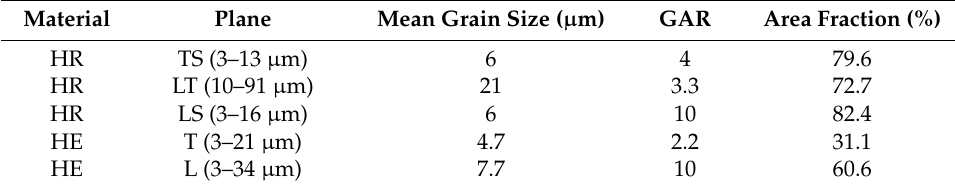
Table 2. Grain size analysis for coarse grains in ODS-KIT (from [17,18]).